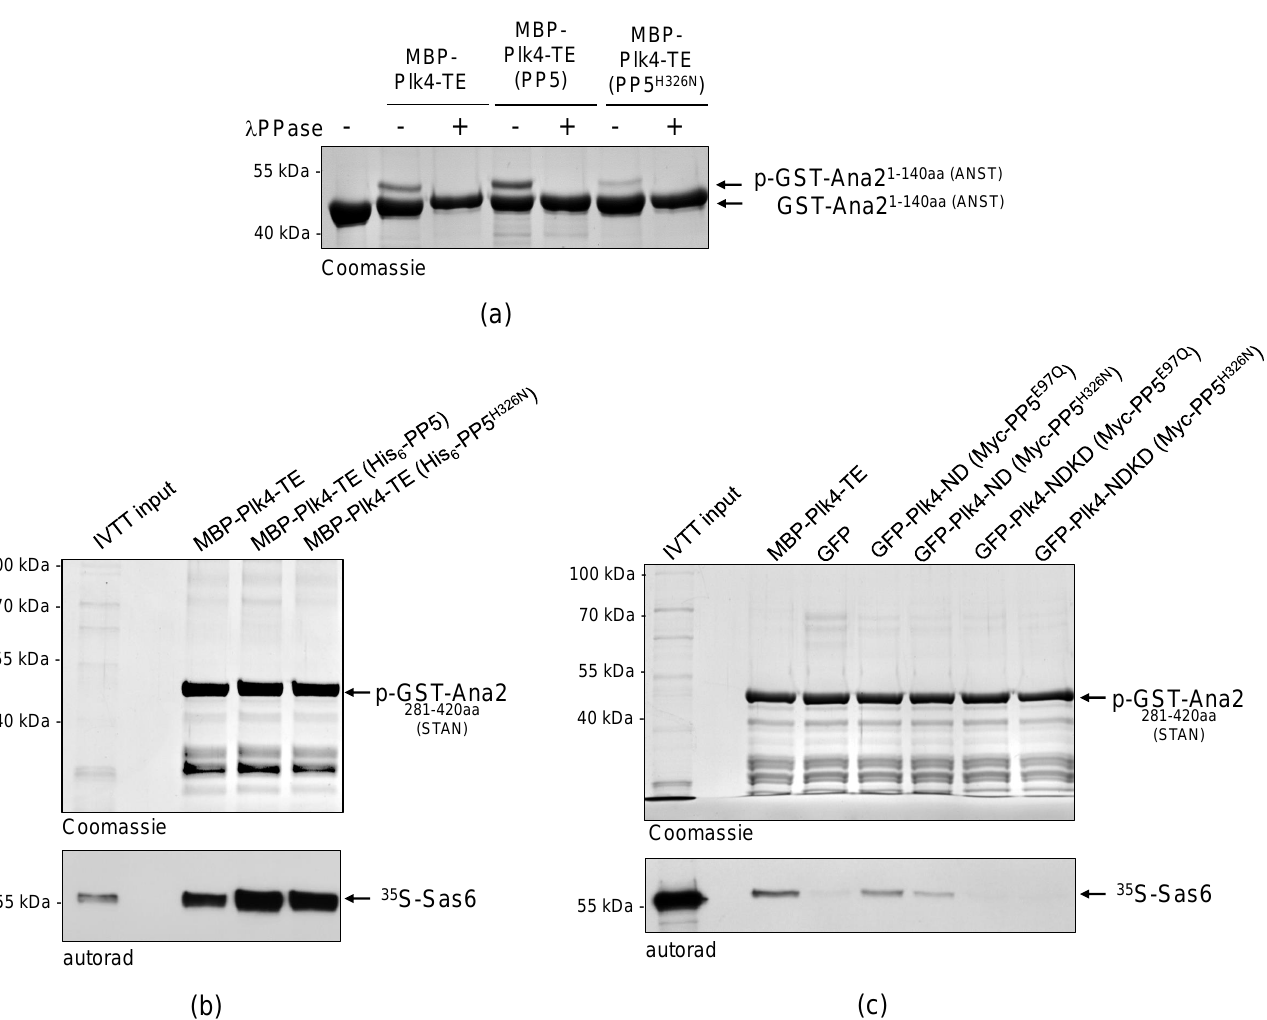
Figure 4. PP5 does not regulate the Plk4 kinase activity. ( a ) The in vitro phosphorylation of